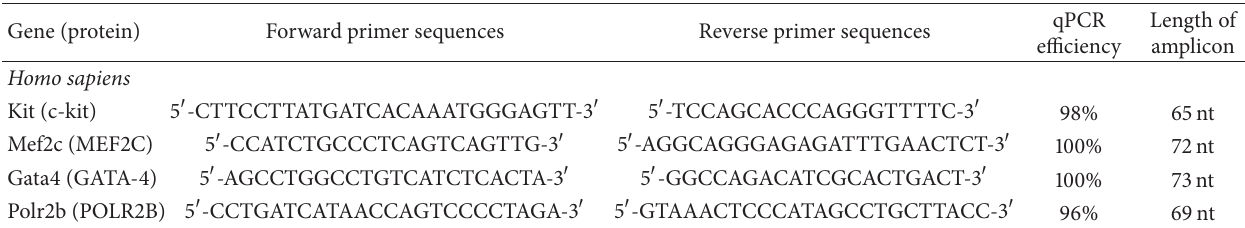
Table 1: Primers used for qPCR